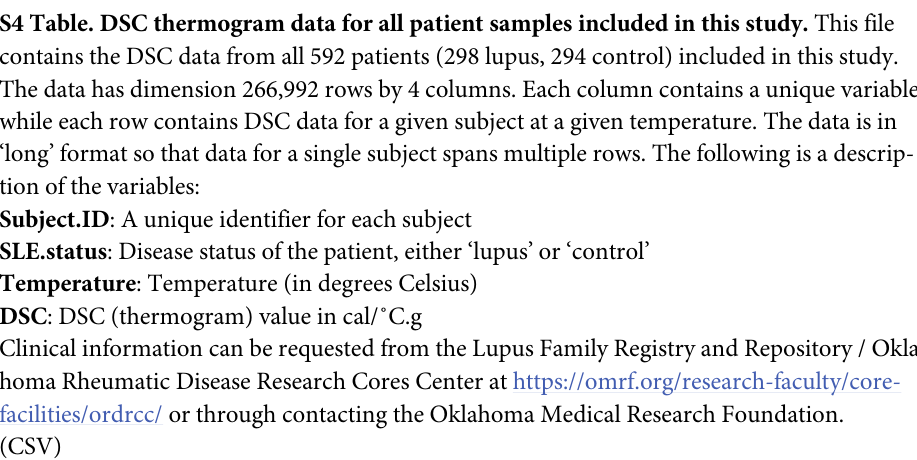
S2 Fig. Plot of the median thermogram value at each temperature for lupus and rheuma- toid arthritis patients. Bands represent the 5th and 95th percentiles among subjects at each temperature. The loadings for the first principal component among all subjects are shown as the black line. S3 Fig. Scree plot for principal components of DSC thermograms based on all subjects (lupus patients and controls). S4 Fig. Density of temperature at maximum peak thermogram height (Tmax) for controls and lupus patients. The density plots reveal roughly three prominent peaks among the sub- jects at 62–67˚C, 69–73˚C, and 75–80˚C (the latter being present only among lupus patients). S5 Fig. Plot of the median thermogram value at each temperature for lupus and control subjects stratified by presence / absence of anemia. Not applicable indicates that the study question did not apply. Bands represent the 5th and 95th percentiles among subjects at each temperature. S6 Fig. Plot of the median thermogram value at each temperature for lupus and control patients stratified by level of anti-cardiolipin immunoglobulin G. Cut-point at the median value of 6). Bands represent the 5th and 95th percentiles among subjects at each temperature. S7 Fig. Sensitivity, specificity, and overall accuracy for classifying lupus patients vs. osteo- arthritis patients based on DSC thermograms only (DSC), antibody tests only (Ab),